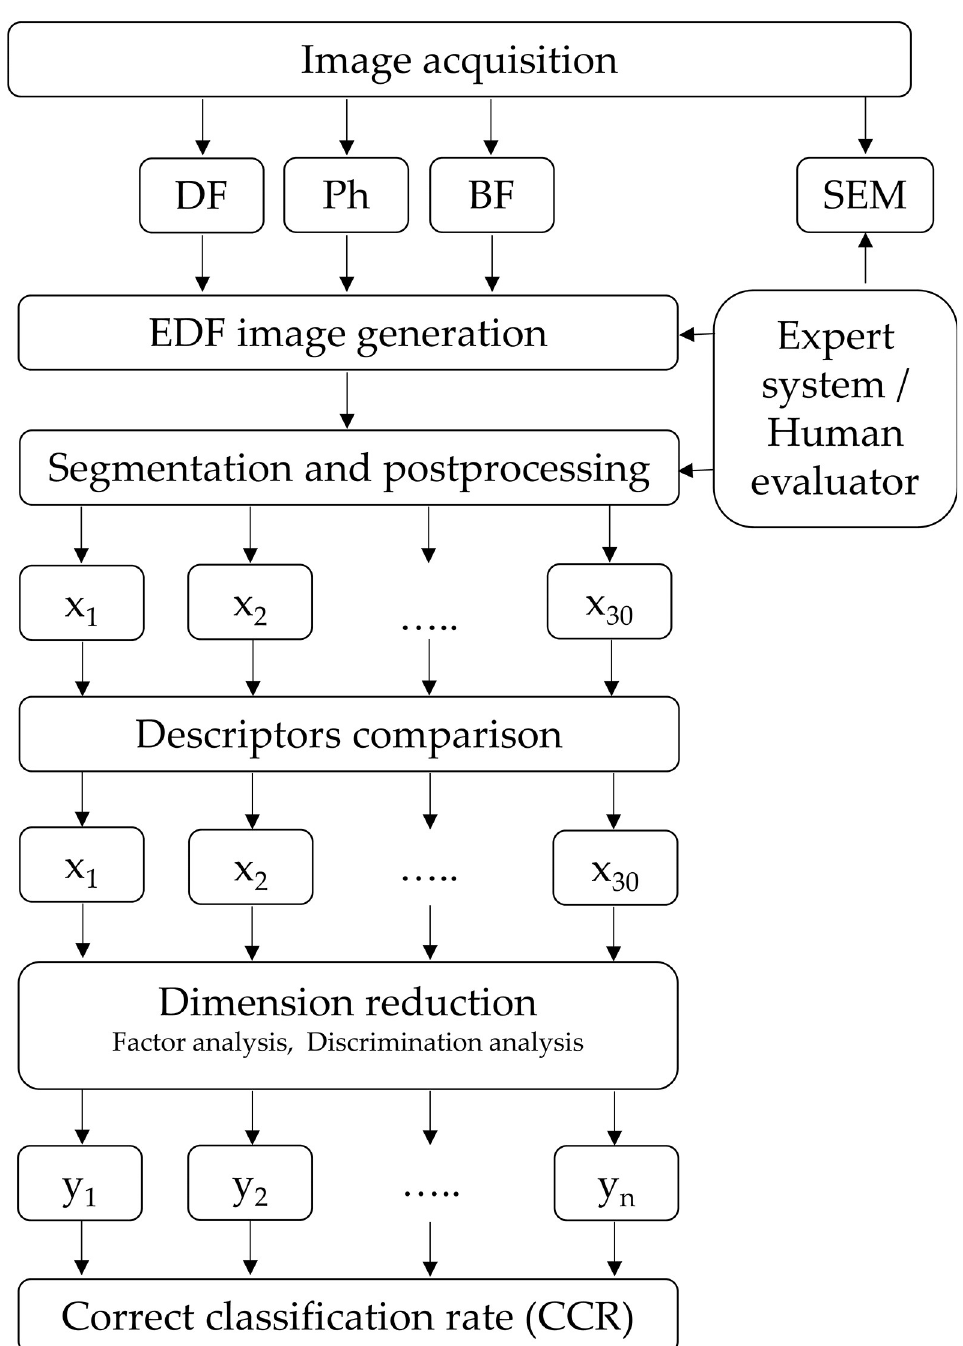
Fig 1. Analysis and classification methodology scheme for pollen